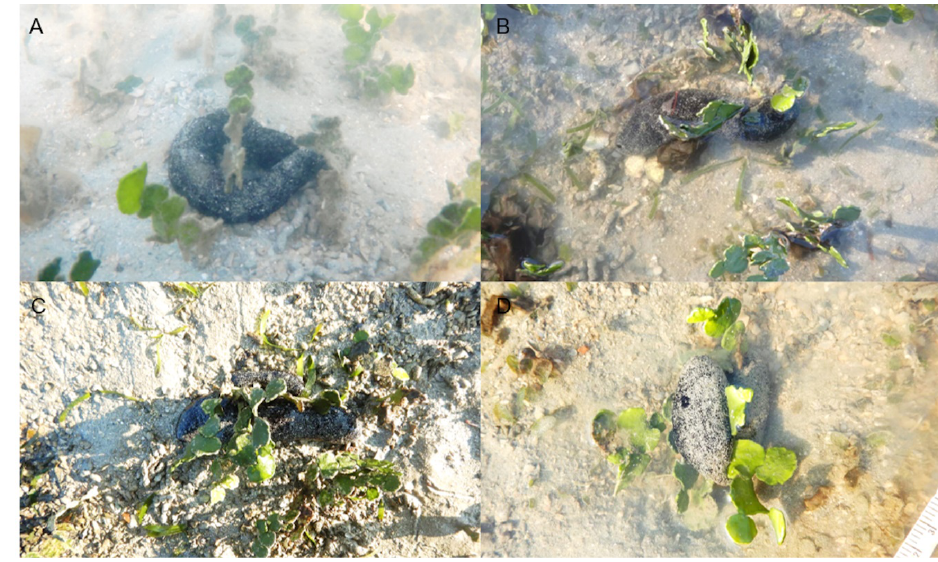
Figure 9. H. atra attaches and wreathes its body around H. macroloba ( A − D ).